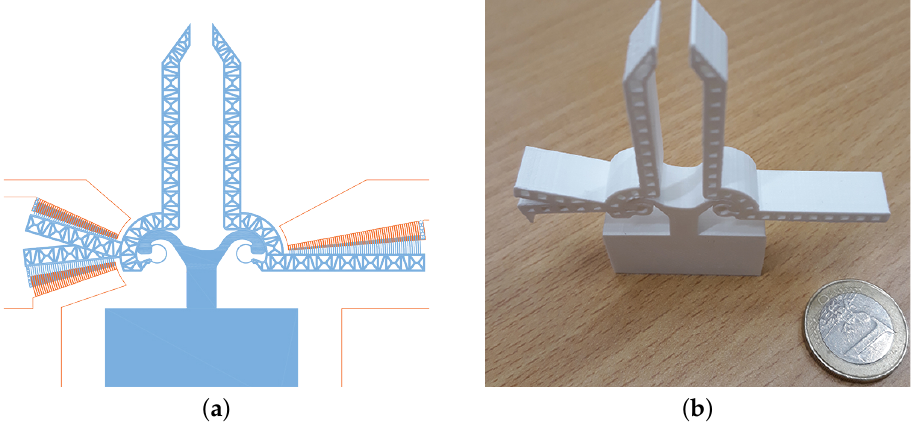
Figure 1. The original mask for a compliant rotary microgripper ( a ); and its prototype at the macroscale ( b ) (first project).